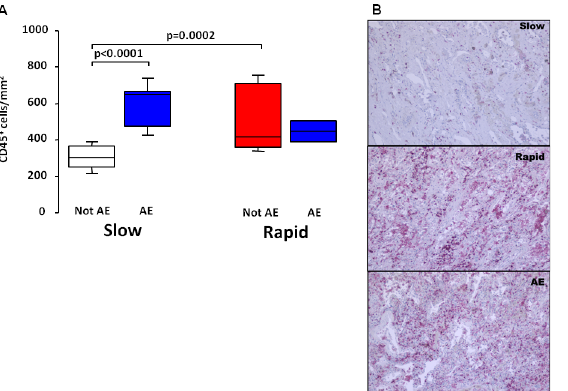
Fig 4. Total inflammatory cells in slow and rapid progressors with and without acute exacerbation (AE). A. Numbers of total leukocytes (CD45 + /mm 2 ) in the lungs of slow and rapid progressors; subjects who developed and those who did not develop AE in each group are considered separately. Horizontal bars represent median values, bottom and top of each box plot 25 th and 75 th , brackets 10 th and 90 th percentiles. Slow not AE: white; rapid not AE: red; AE: blue. B. Microphotographs showing total leukocyte (CD45 + ) infiltration (in red) in the lung of a slow decliner, a rapid decliner and an AE patient. Original magnification X10; immunostaining with